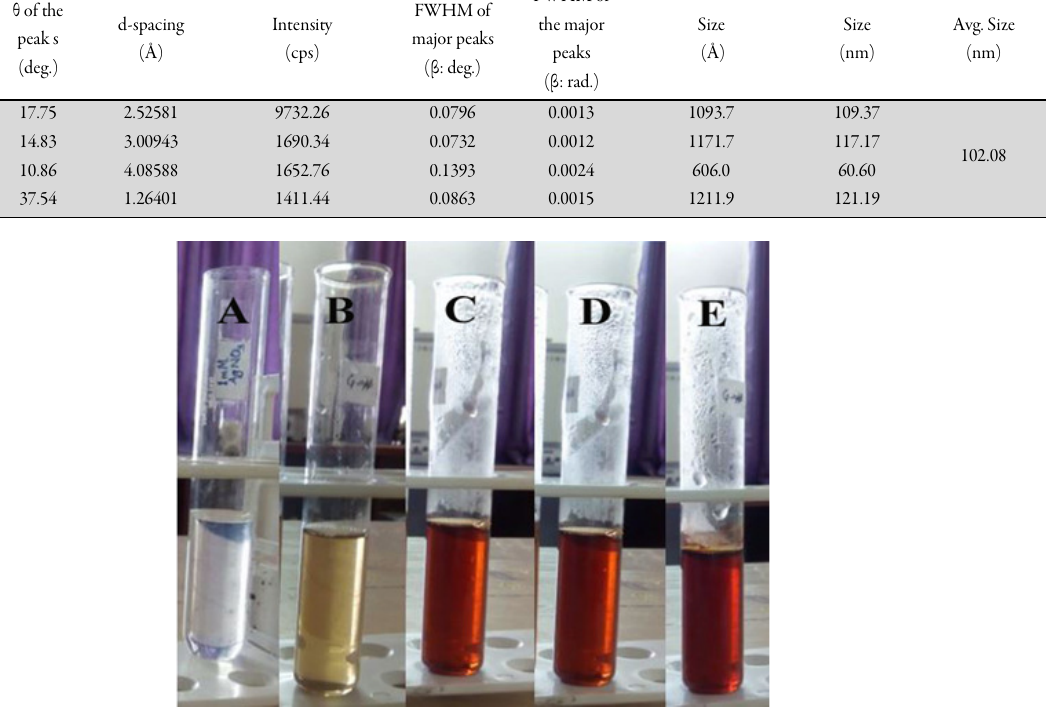
Fig. 3. Change in colour of mixed solution: (A) AgNO 3 solution; (B) AgNO 3 solution and extract at room temperature; C, D and E-mixed solution after heat stirring of 30 minutes, 1 hour and 2 hours respectively